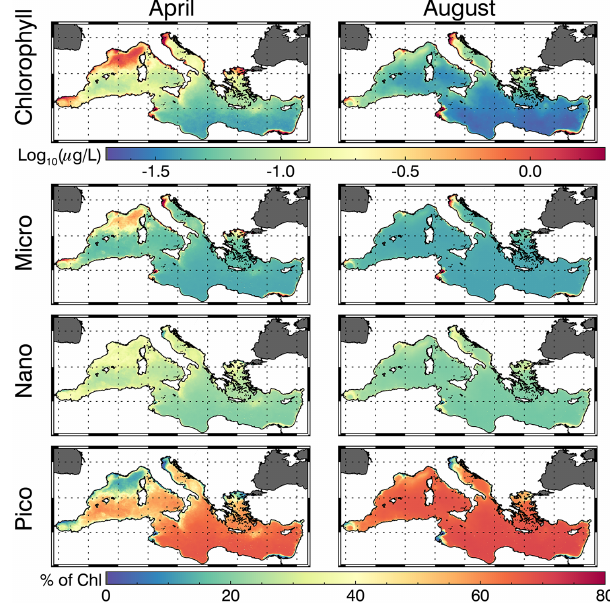
Figure 4. Seasonal spring to summer excursion of TChl a and PSCs in the Mediterranean Sea. On the left panels, the April climatol- ogy (1998–2010) maps of TChl a (µgL − 1 ) and PSCs (%). On the right panels, the August climatology (1998–2010) maps of TChl a (µgL − 1 ) and PSCs